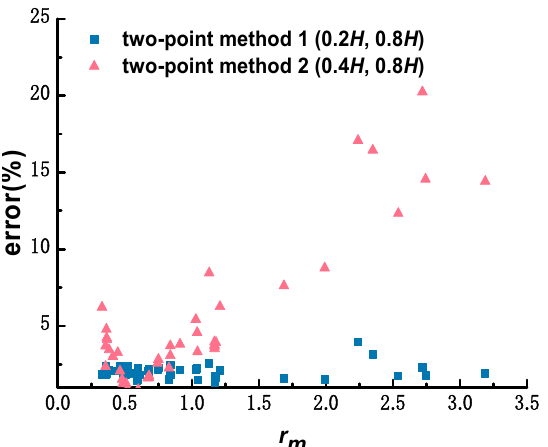
Figure 3. Comparison of velocity-estimation error related to two one-point methods.